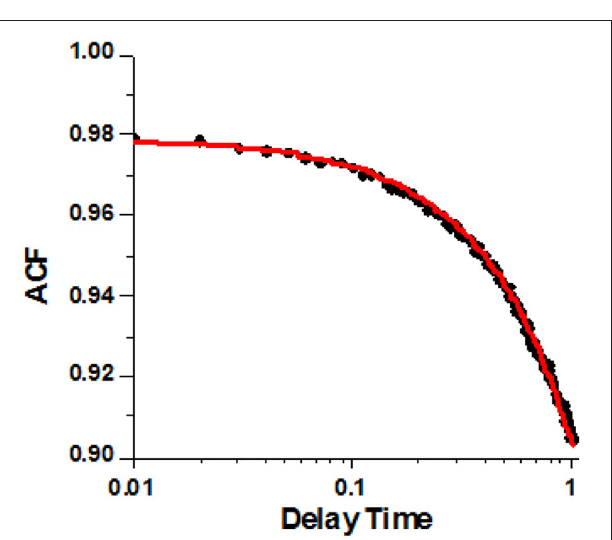
dissociation of myosin from actin (C → A) occurs with the rate k DISS .